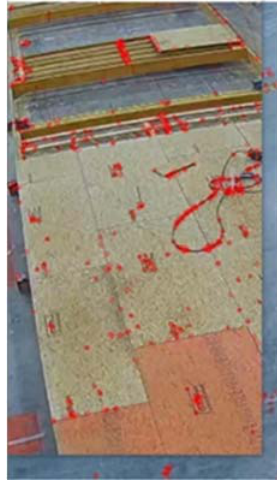
Figure 13. SIFT output where red circles indicate the SIFT keypoints.